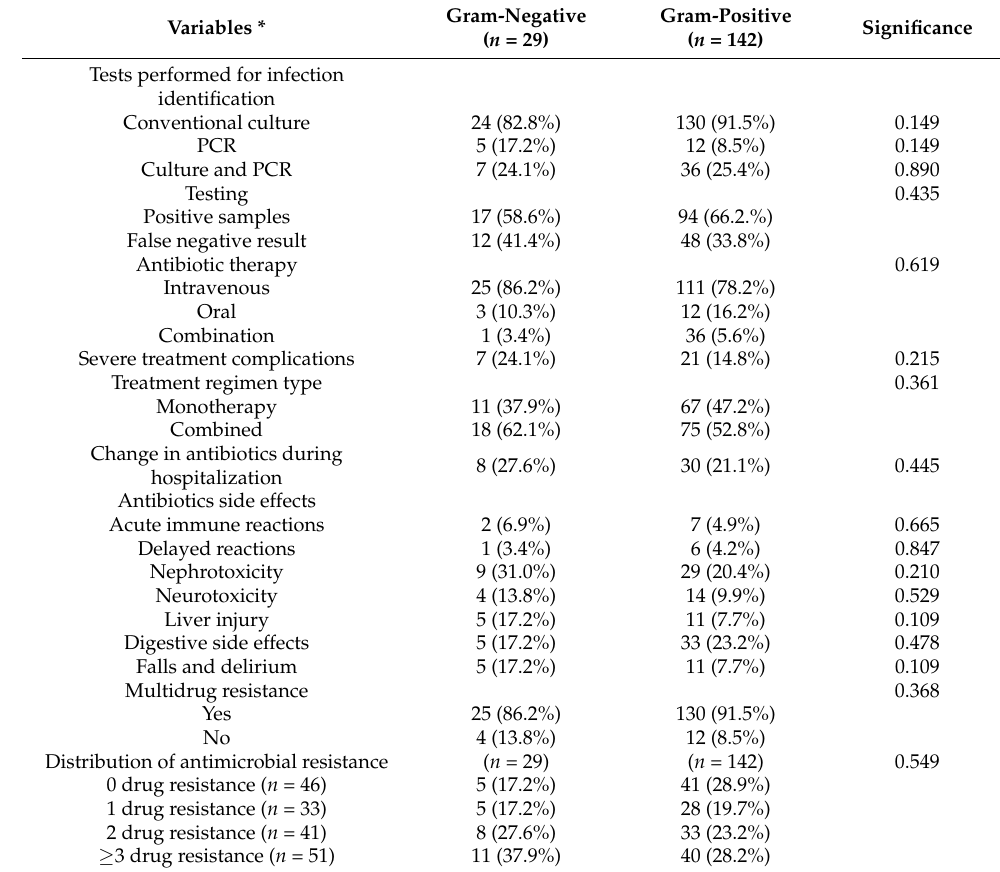
Table 4. Microbial detection, treatment, and antimicrobial resistance features.